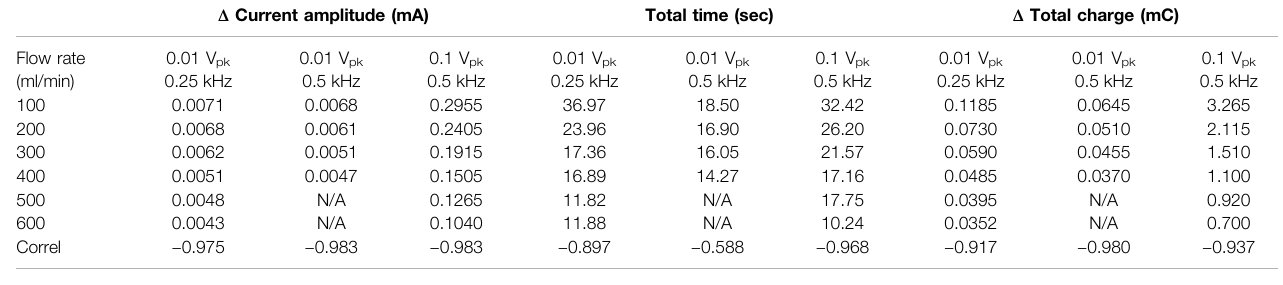
TABLE 1 | Effect of AC voltammetry settings on electrodilution metrics.